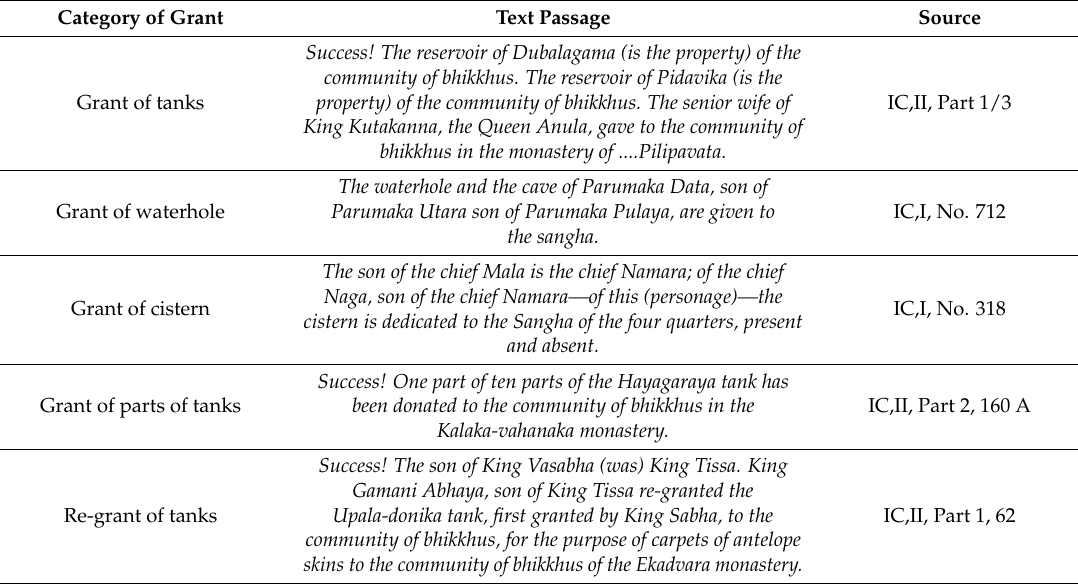
Table 2. Different categories of grants of irrigation to the Buddhist monastic entities recorded in ancient